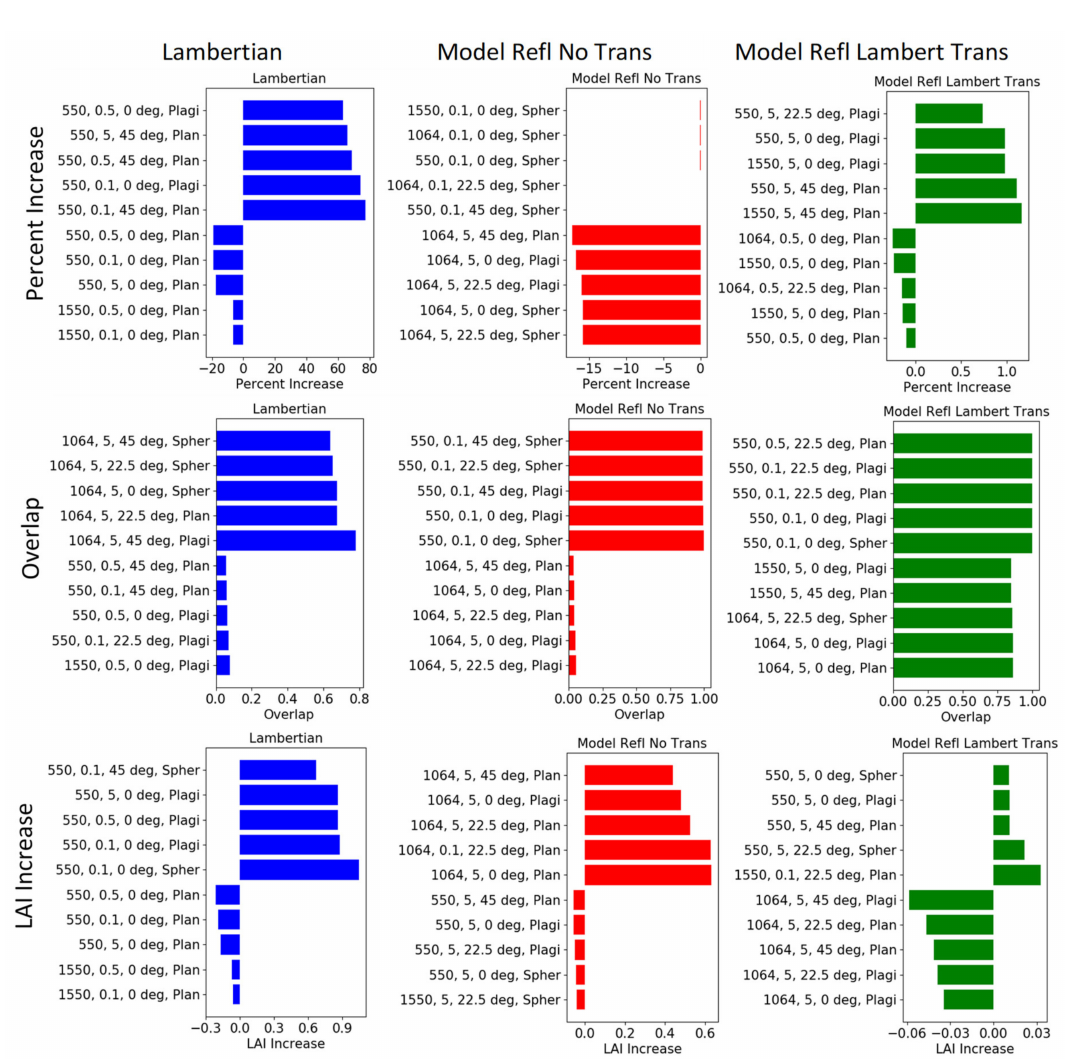
Figure 16. Bar graphs of the five highest and lowest values (top five and bottom five bars in each plot, respectively) for each leaf BSDF simplification type, left-to-right: Lambertian, model-opaque, and model-Lambertian; each metric, top-to-bottom: percent increase, overlap, and LAI increase. Note, the axes are scaled di ff erently for each graph as the scales between the di ff erent leaf types are drastically di ff erent for many of the metrics. Labels for the simulations are wavelength (nm), footprint size (m), zenith angle (degree), and LAD type (spherical (Spher), planophile (Plan), and plagiophile